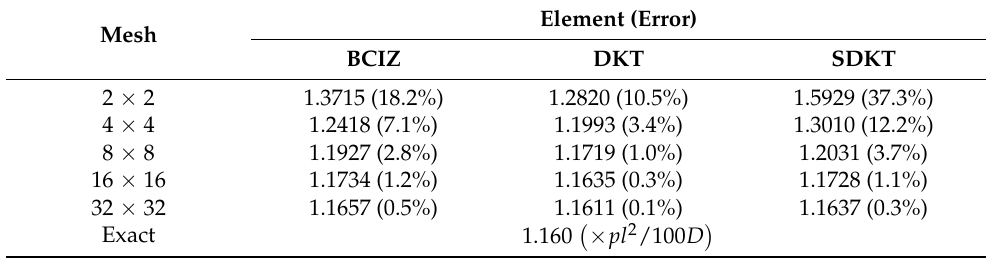
Table 4. Central deflection for a simply supported square plate under center point load.